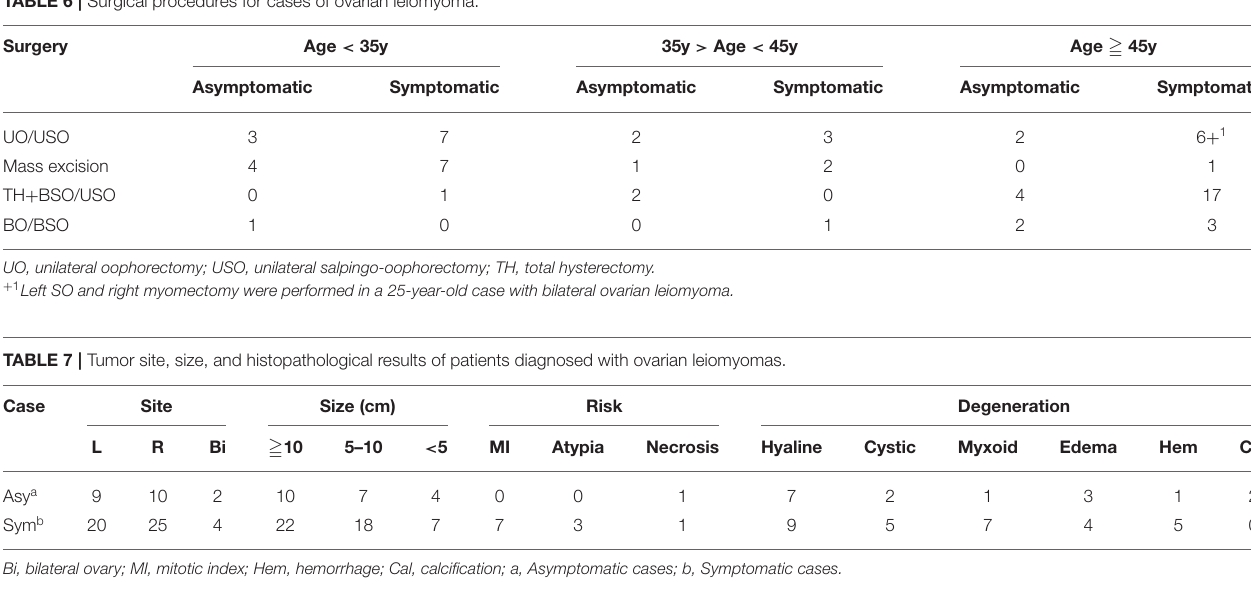
TABLE 6 | Surgical procedures for cases of ovarian leiomyoma.